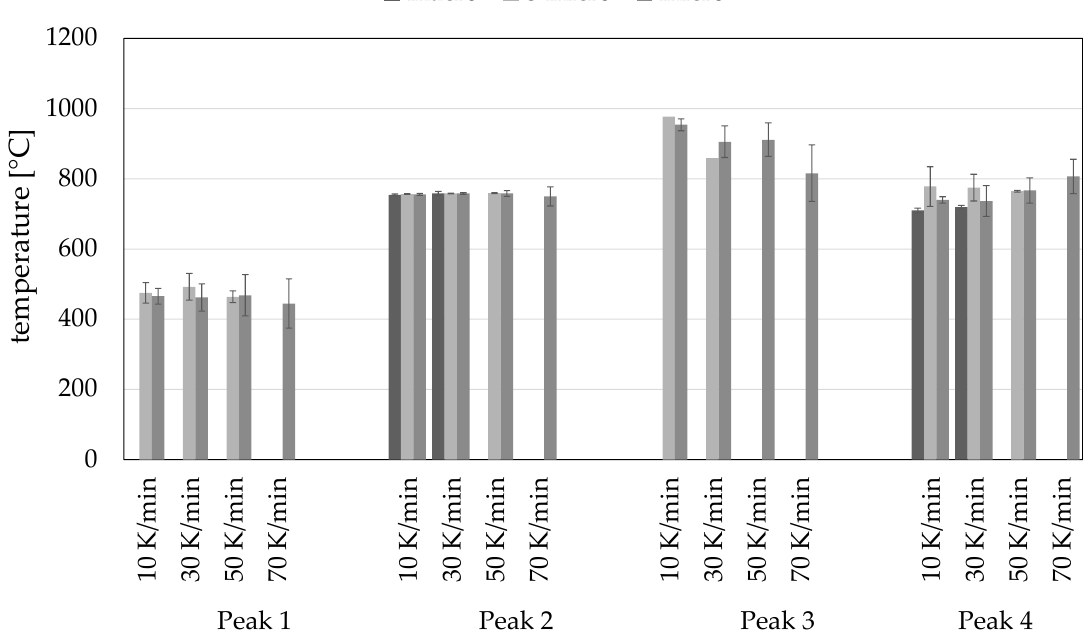
Figure 8. Onset temperature for varying heating rates (10, 30, 50 K/min) and mass input (one micro sample, three micro samples and one macro sample) computed as an arithmetic mean from n > 3 samples.